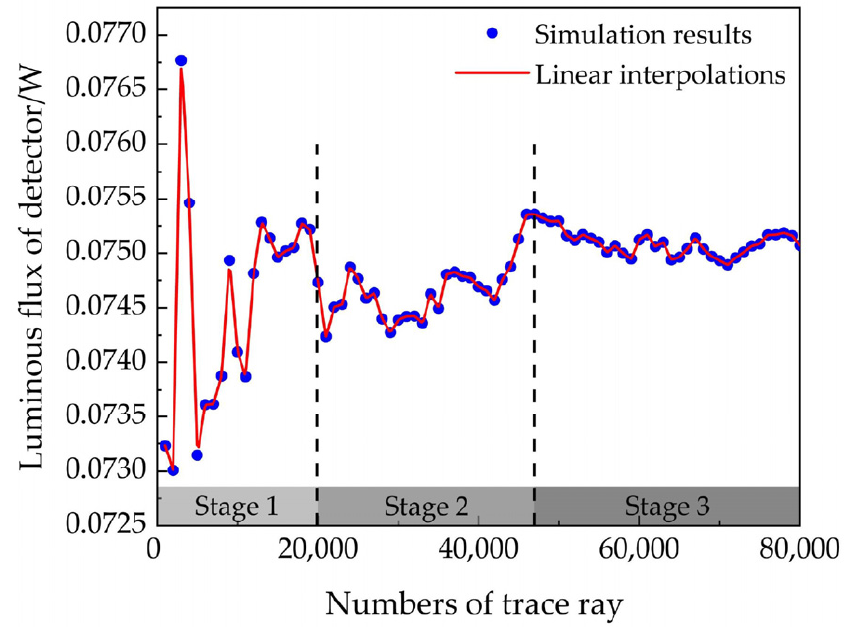
Figure 6. Influence of trace ray number on simulation results.